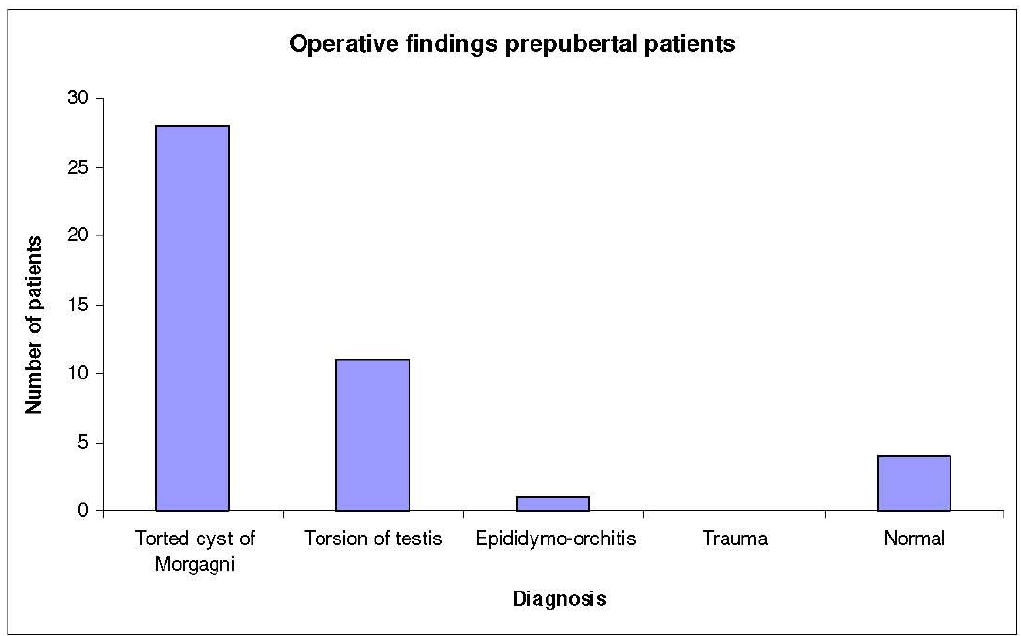
FIGURE 1. Operative findings in scrotal exploration in prepubertal patients (n = 44).